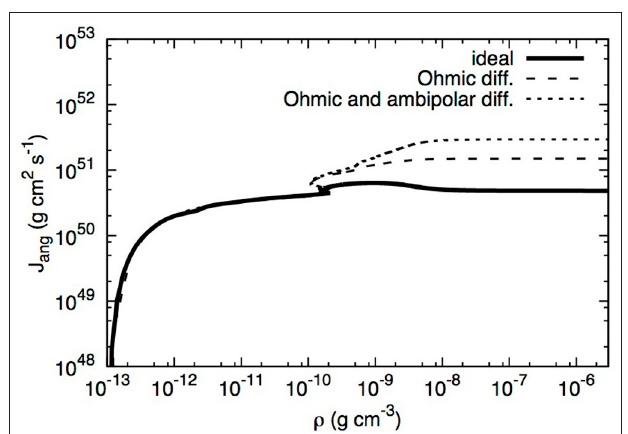
FIGURE 6 | The angular momentum in the first hydrostatic core for models using ideal MHD, Ohmic diffusion, and Ohmic and ambipolar diffusions. The Ohmic+ambipolar model has enough angular momentum to form a ∼ 1 au rotationally-supported disc, whereas discs do not form in the other two models. This figure is inspired by Figure 6 of Tsukamoto et al. (2015b), and was created by Y. Tsukamoto for this publication using the data published in Tsukamoto et al.